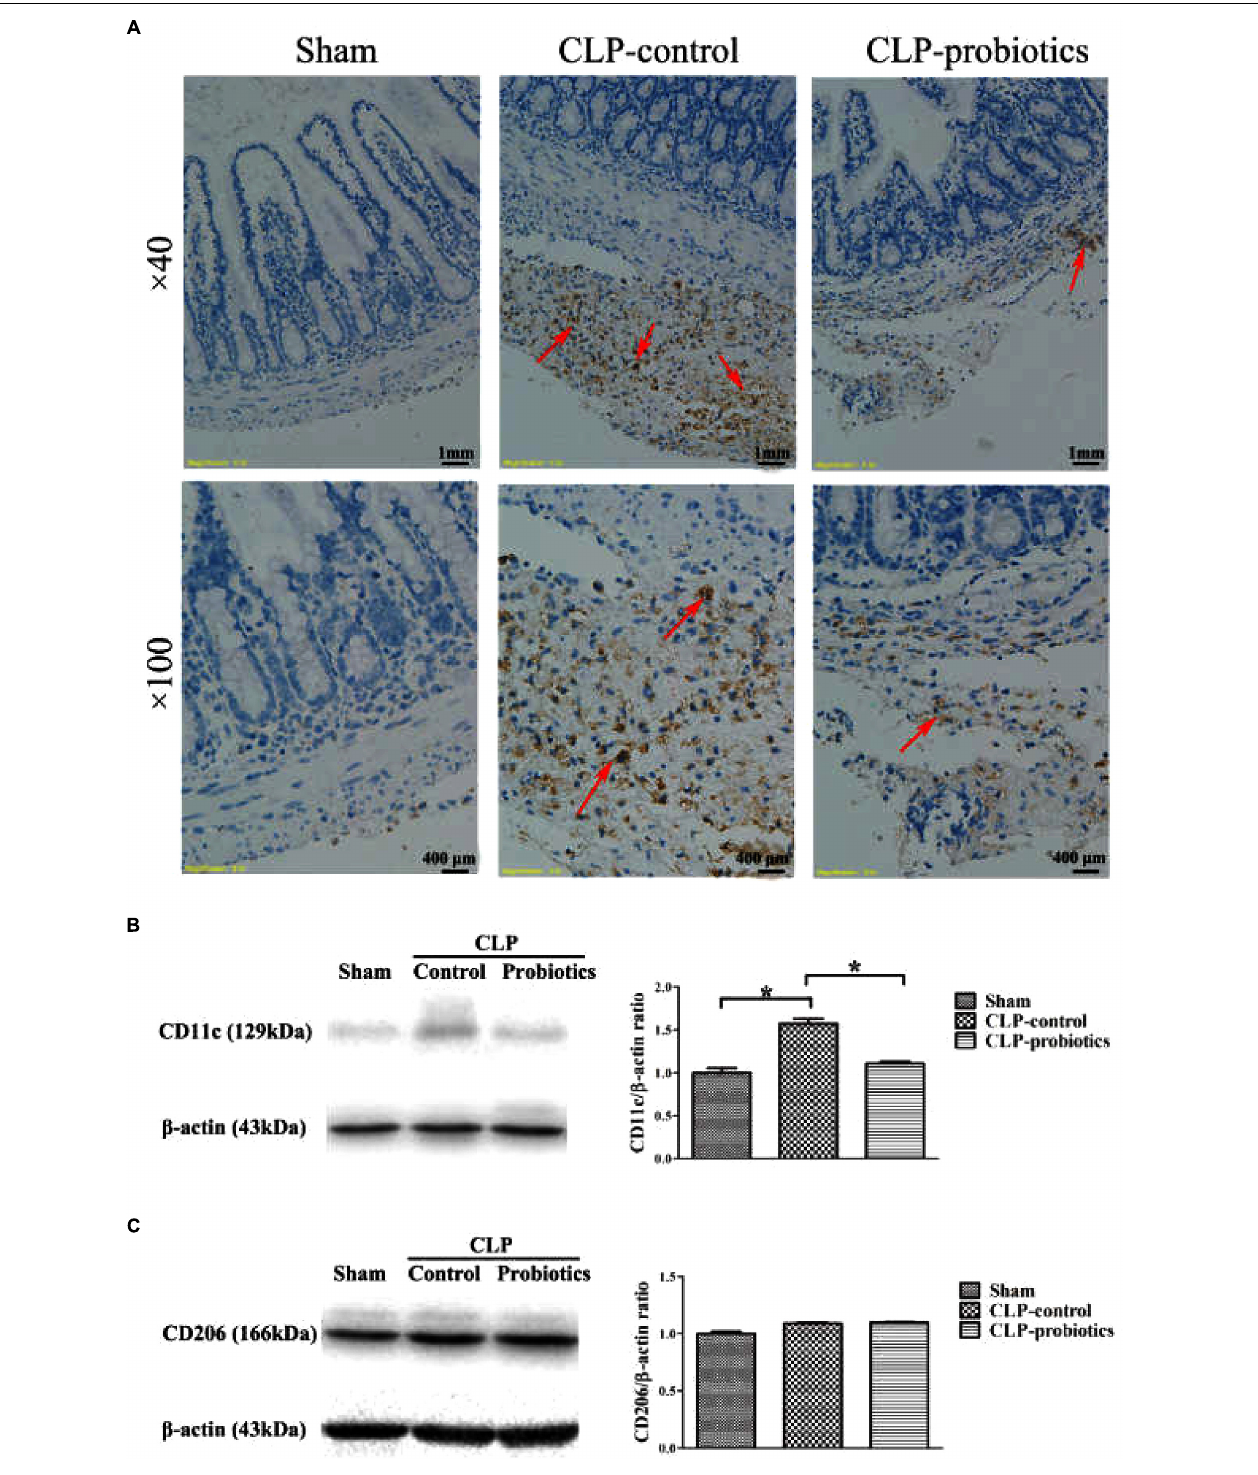
FIGURE 5 | The effect of LCBE pretreatment on the macrophage activation and transformation. (A) CD68was stained in ileal tissues by IHC assay under 40 × and 100 × magnifications. (B) The protein expression of CD11cwas examined by Western blotting. Representative photographs of CD11c and β -actin blots were displayed in left panel. The bar graph was presented in right panel. (C) The protein expression of M2 type macrophage marker CD206 was examined. Representative photographs of CD206 and β -actin blots were exhibited in left panel. The bar graph was presented in right panel. All data were showed as means ± SEM. N = 6 mice/group; N = 6 mice/group; ∗ P < 0.05.